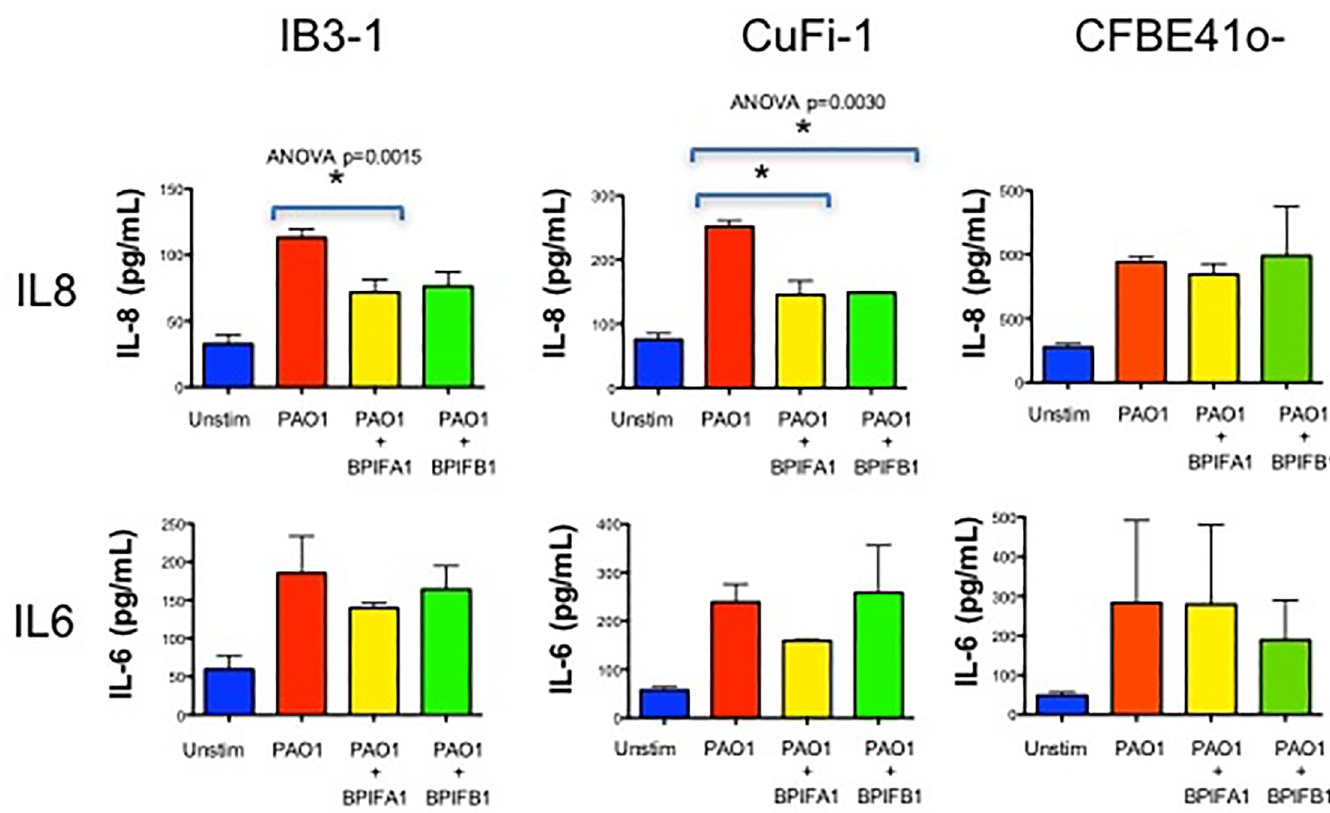
Fig 5. Quantification of inflammatory cytokine production by airway epithelial cells pretreated with recombinant BPIFA1 or BPIFB1 prior to bacterial stimulation. Quantification of IL-8 and IL-6 by ELISA produced by IB3-1, CuFi-1 and CFBE41o- airway epithelial cell lines that were unstimulated, stimulated with heat-killed P . aeruginosa , pretreated with recombinant BPIFA1 for 30 min followed by stimulation with heat-killed P . aeruginosa , or pretreated with recombinant BPIFB1 for 30 min followed by stimulation with heat-killed P . aeruginosa . ANOVA was used to identify statistical differences in IL-6 and IL-8 levels between conditions with � denoting P <